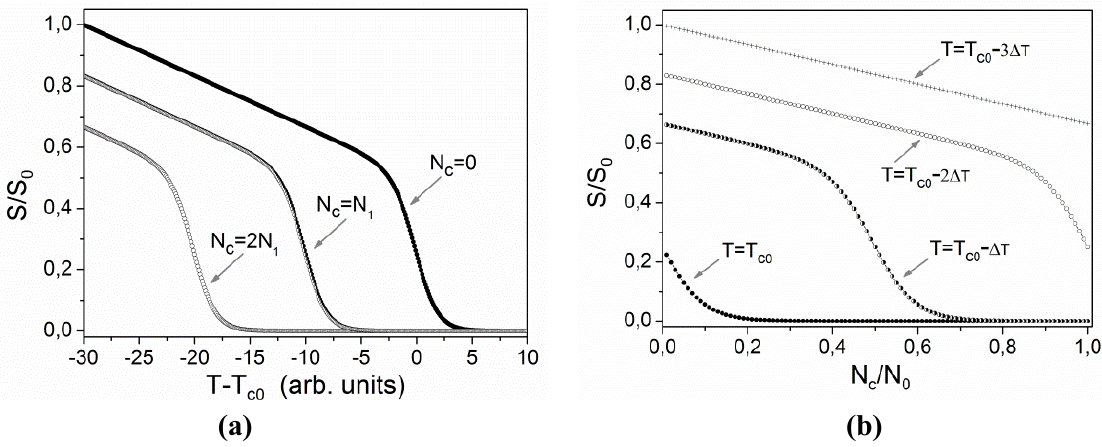
Figure 8. Qualitative illustration of the effects of temperature T and concentration N isomers on the order parameter S : ( a ) dependence on temperature at three fixed values of concentration; ( b ) dependence on concentration at four fixed